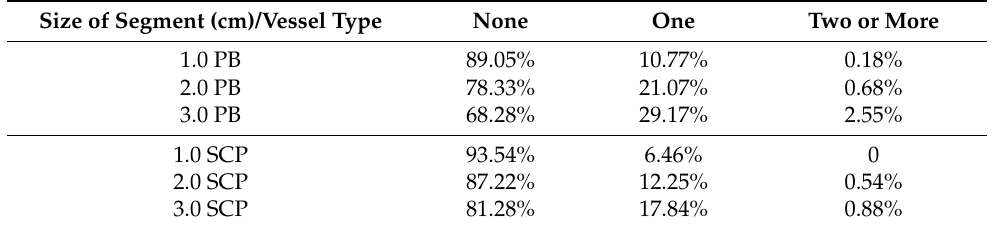
Table 4. Number (%) of fibular segments that were supplied by periosteal branches (PB, n = 361) and corresponding septo-cutaneous perforators (SCP, n = 213) of FA of all lower legs ( n = 144). Size of Segment (cm)/Vessel Type